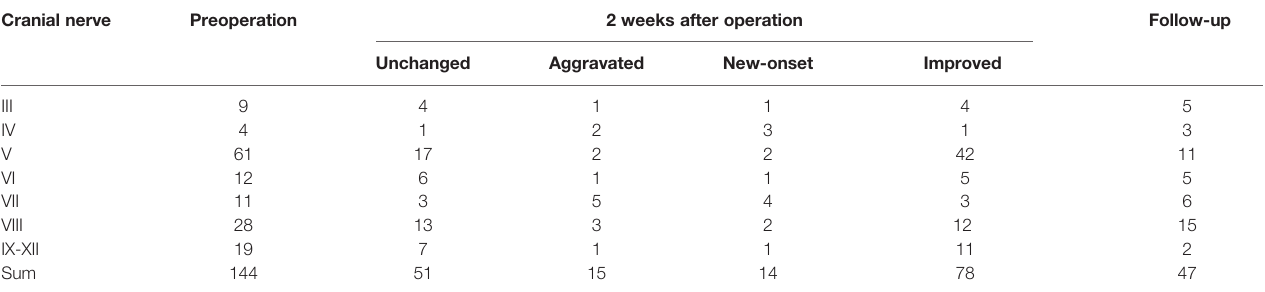
TABLE 3 | Dysfunctions of the cranial nerves. Cranial nerve Preoperation 2 weeks after operation